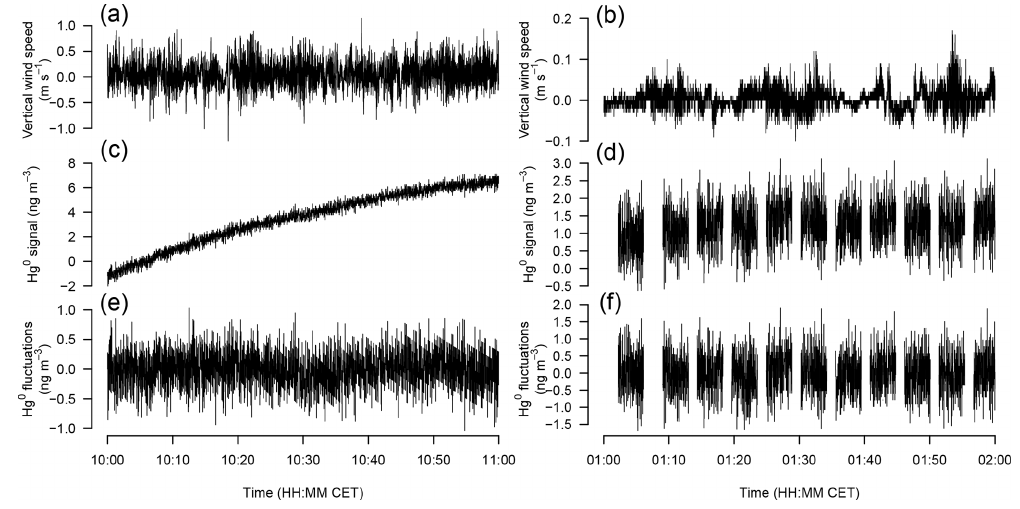
Figure 2. Examples of raw data time series over a 1h data segment: (a, c, e) during period 1 with 24h calibrations only (21 July 2018, 10:00–11:00), and (b, d, f) during period 4 with 4min instrument calibration intervals (6 September 2018, 01:00–02:00). Vertical wind speed (a, b) was not detrended. Hg 0 concentrations are shown before detrending (c, d) and after detrending (e, f) . While the 4min calibration intervals clearly reduce the longer-term drift (d) compared with daily calibrations (c) , the gaps during calibrations had to be filled using linear interpolation before calculating